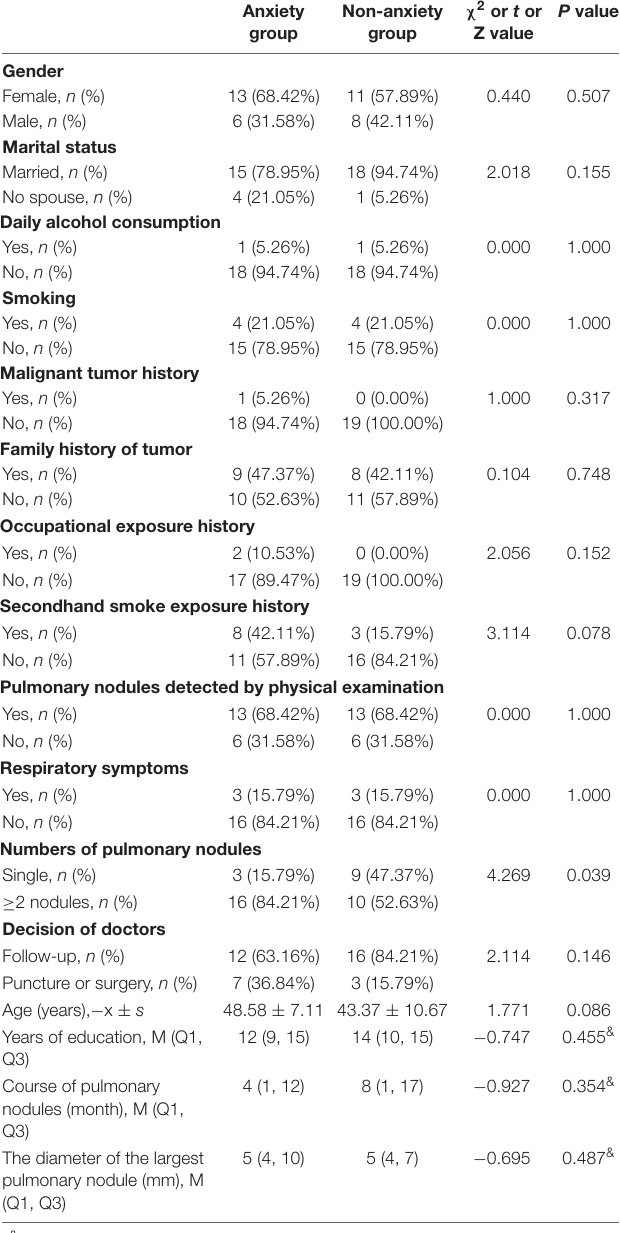
TABLE 1 | Comparison of demographic characteristics and clinical data between anxiety group and non-anxiety group. Anxiety